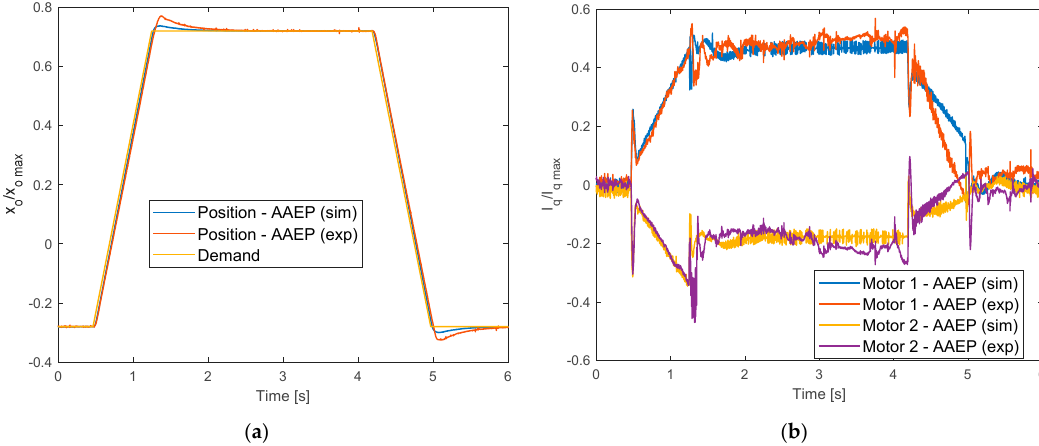
Figure 7. Time-domain model validation: position tracking in ASB mode with 100 kN/m spring-type loading (in Equation (24), k e = 10 5 N/m); ( a ) output position; ( b ) motors quadrature currents ( x o max = 25 × 10 − 3 m; I q max = 25 A).